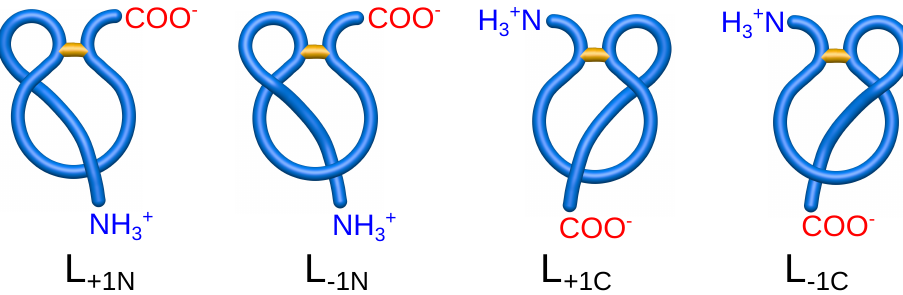
Figure 3. Subclasses of the L 1 major type. From left to right are L + 1 N , L − 1 N , L + 1 C , and L − 1 C